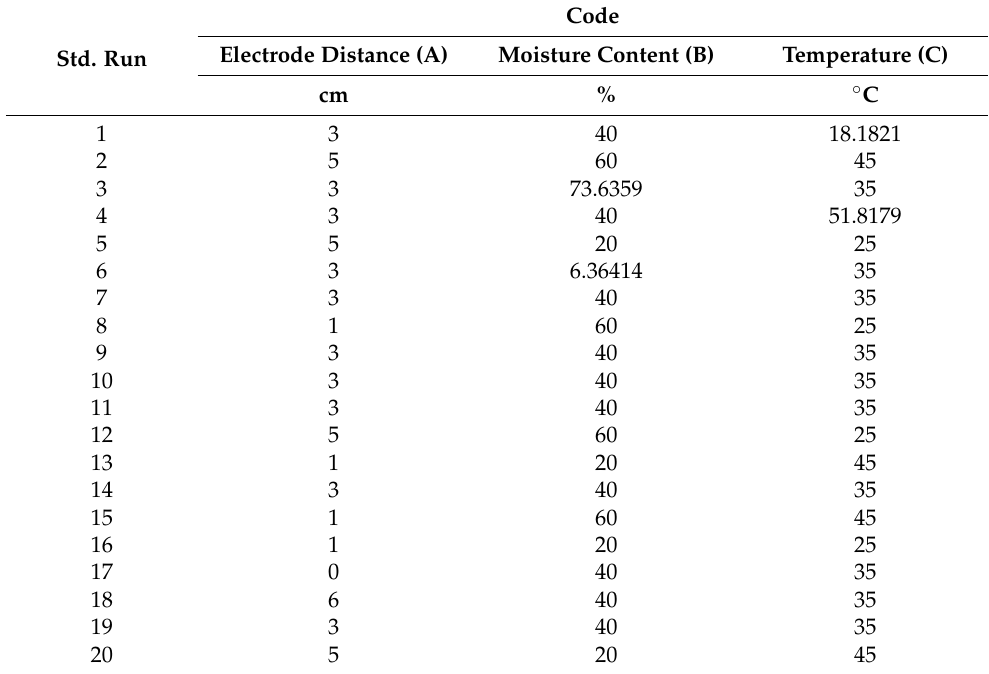
Table 8. Proposed conditions of electrode distance (cm), moisture content (%), and power density (mW/m 2 ) for the ML-MFC systems determined by CCD. Code Electrode Distance Std. Run